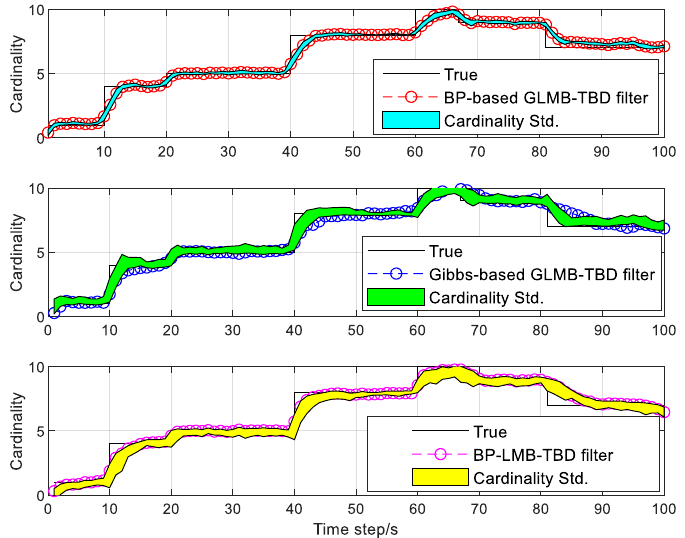
Figure 7. Cardinality statistics for the different methods over 100 Monte Carlo trials.